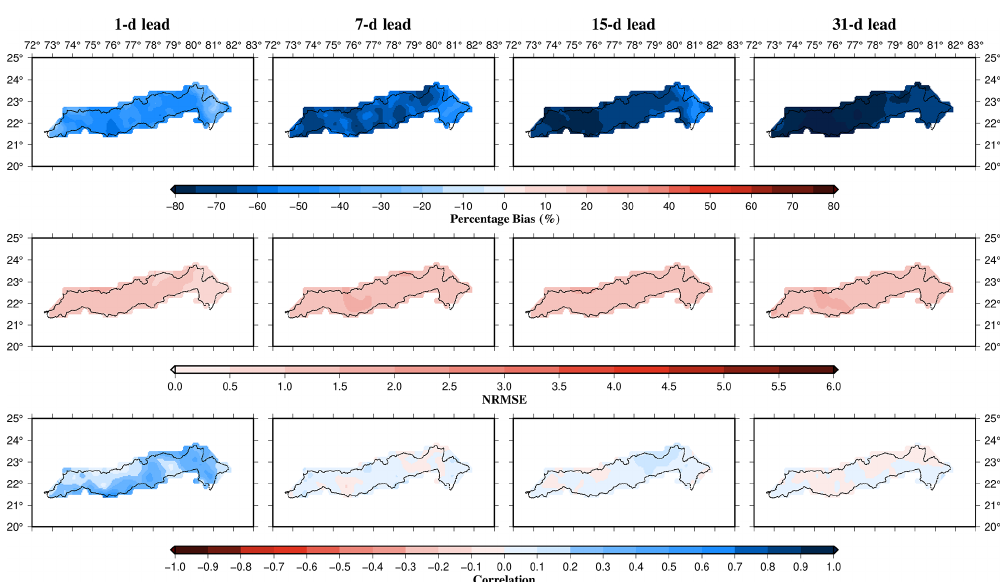
Figure 3. Evaluation of extreme precipitation ( > 90th percentile) forecast skill from ERFS for the 2003–2018 period. Forecast skills were evaluated using bias, NRMSE, and correlation for each ensemble member and the median skill is